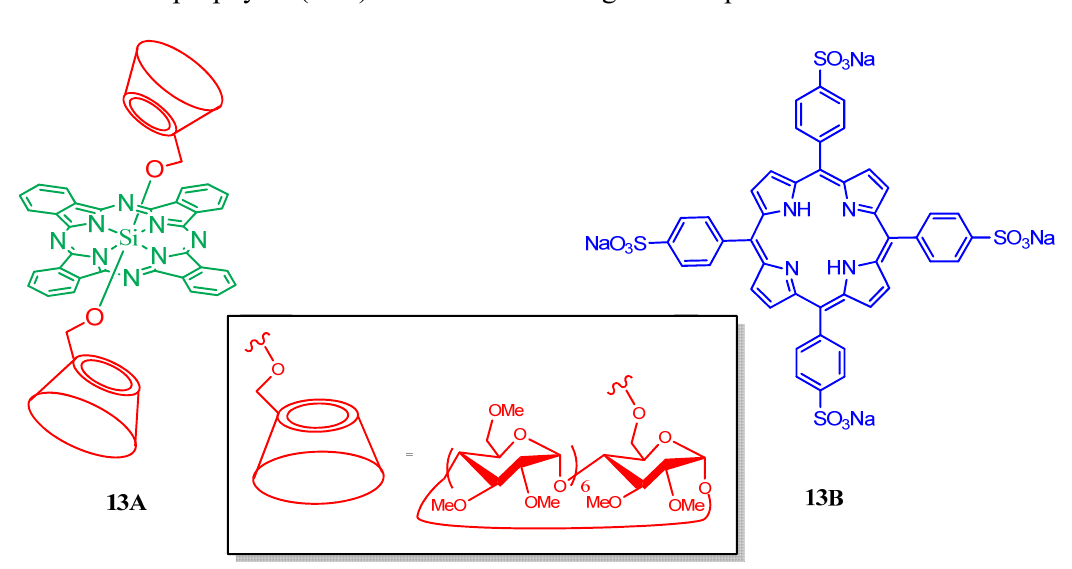
Figure 14. Si(IV) phthalocyanine conjugated permethylated β -cyclodextrin ( 13A ) and tetrasulfonated porphyrin ( 13B ) used to make host-guest